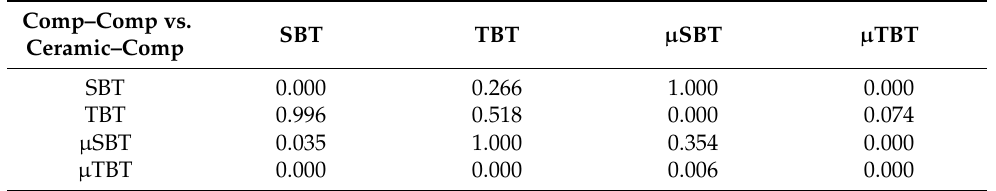
Table 6. Cross-comparison of significant differences between mean bond strengths of composite-to- composite versus ceramic-to-resin composite based on the test